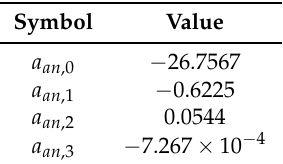
Table A3. AN press. drop coefficients.